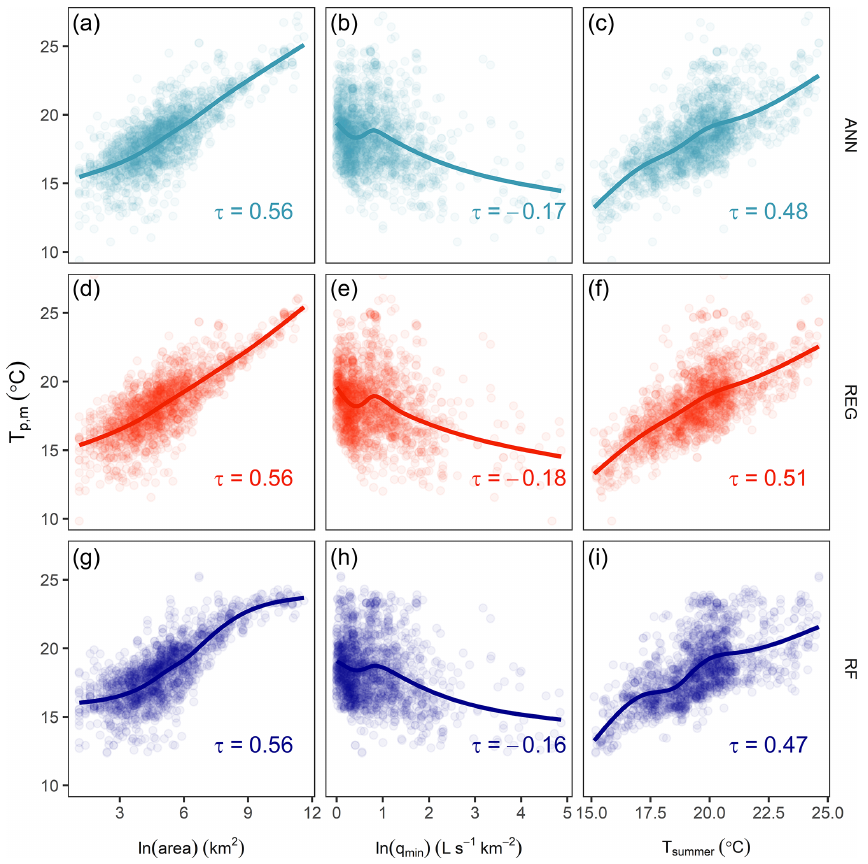
Figure 5. Modeled T p at each of the 1700 observation stations as a function of the variables hypothesized to be equally important across approaches. Rows indicate the model used (points also colored accordingly), and columns are separated by area, q min , and T summer ; area and q min are natural-log-transformed. Lines indicate best-fit smoothers using a generalized additive model, and text indicates Kendall’s tau correlation values (all p < 0.001). There was no systematic difference in variable effects on T p , m